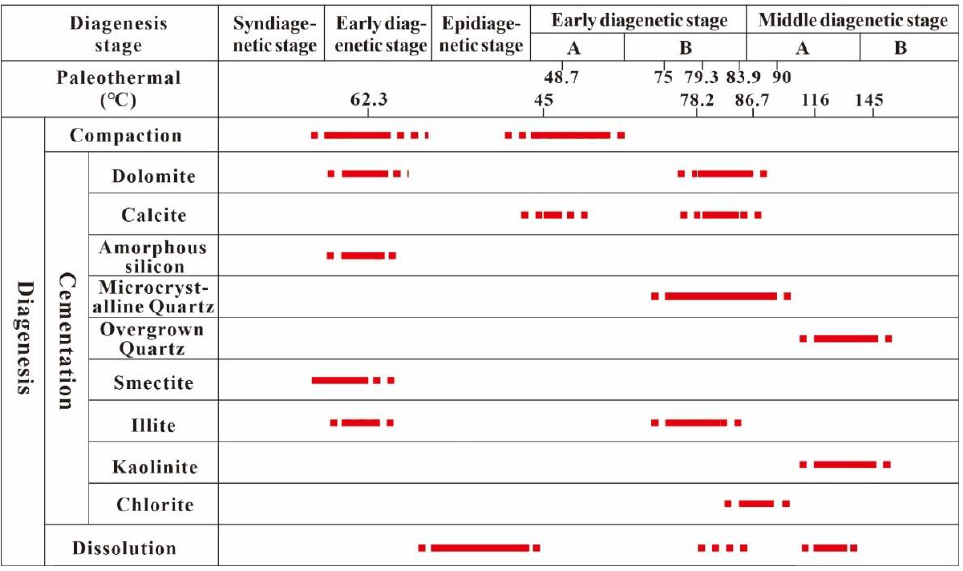
Figure 14. Compositional distribution patterns of overgrown quartz and kaolinite.